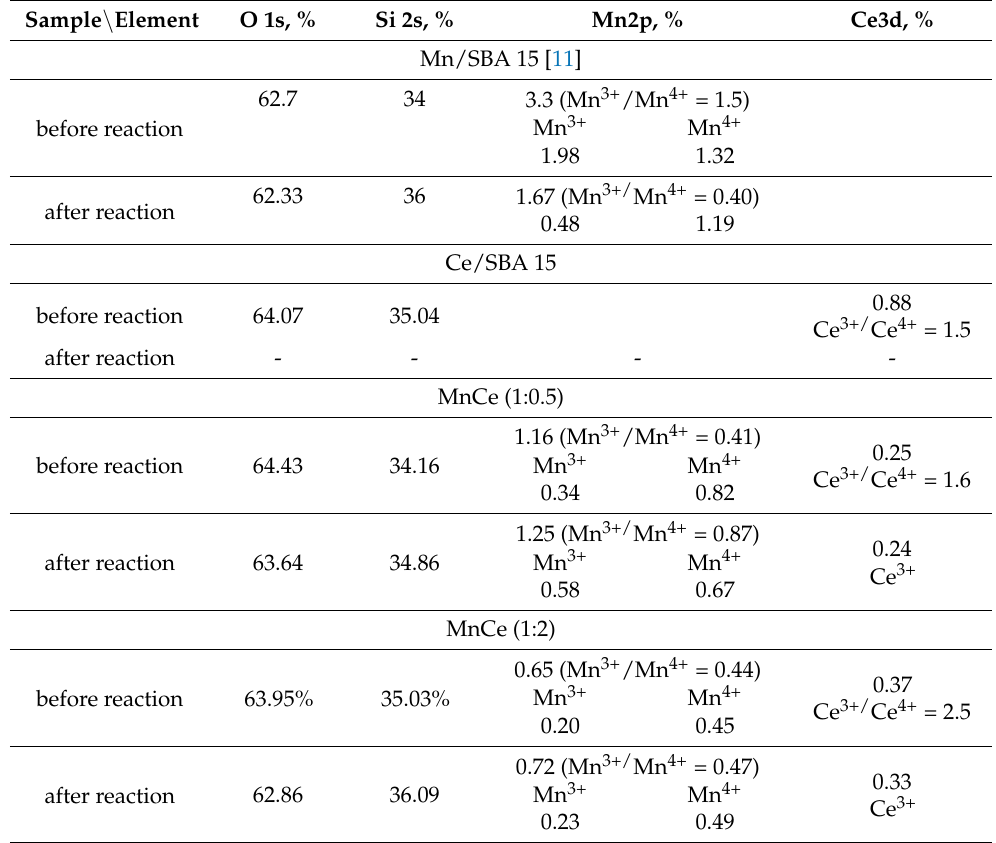
Table 2. Surface atomic concentrations (at.%) of O 1s, Si 2s, Mn2p and Ce3d. Sample \